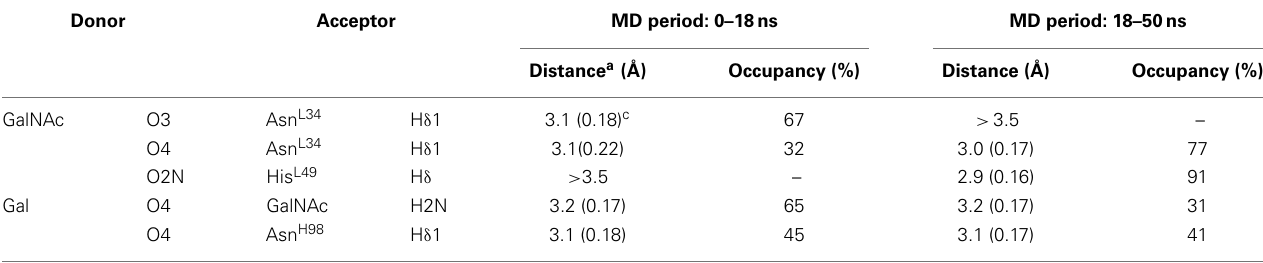
Table 2 | Hydrogen bonds between BGA and the scFv during the MD simulation